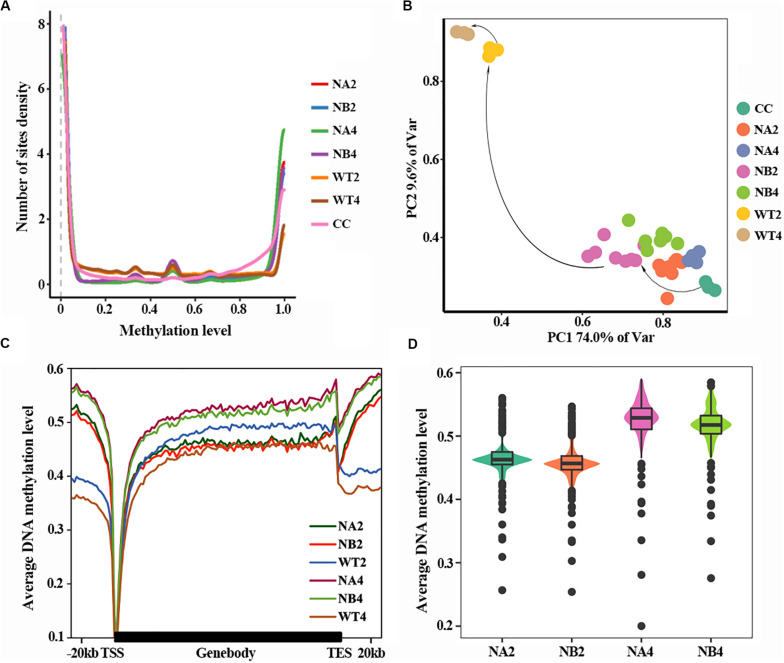
Aberrant DNA methylation occurs in SCNT embryos. (A) DNA methylation density distribution of different types of embryos. Higher probability density distribution of hyper-methylated regions was observed in nuclear transferred embryos. (B) PCA plot of DNA methylation from all samples used in this study. Different colors represent different samples indicated in the right. (C) Average DNA methylation levels were determined along the gene bodies, mm9 reference genome were split to 100 bins with equal proportion, the upstream and downstream 20 kb of the genes were split into 20 bins with the length of 1 kb. Methylation levels were average methylation levels on 1 bin. (D) Violinplot of DNA methylation levels of SCNT embryos at 2-cell and 4-cell stages.